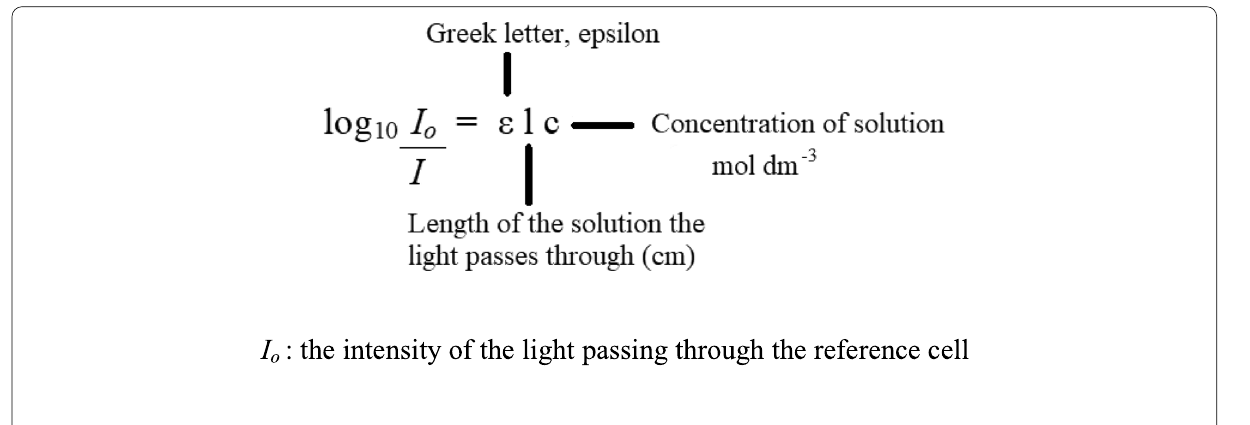
Fig. 2 The absorbance of the solution with epsilon value was calculated using the equation above according to Beer Lambert law